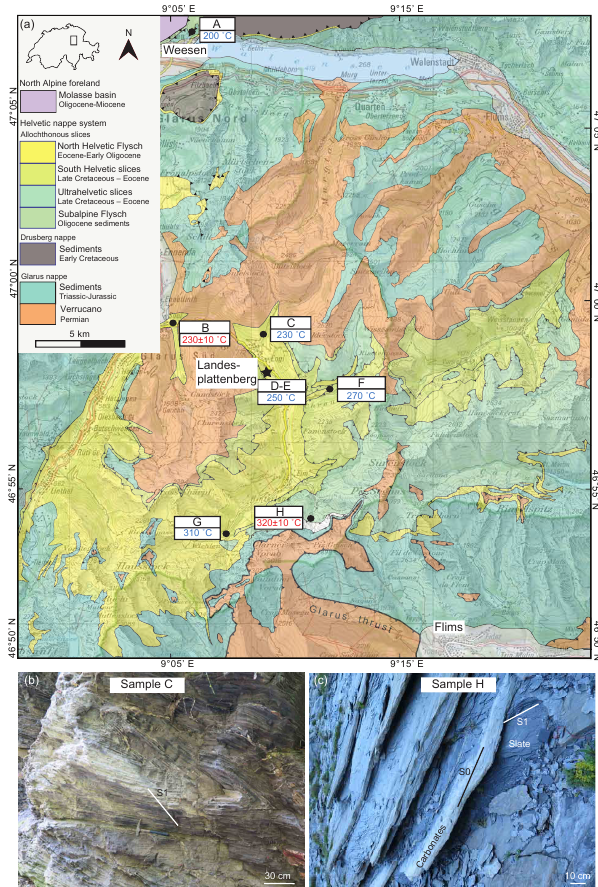
Figure 1. Geological map and outcrops. (a) Geological map with sample locations. Map adapted from Dielforder et al. (2016); temperatures from samples in close vicinity taken from Ebert et al. (2007) (in red) and from Lahfid et al. (2010) (in blue). Star indi- cates location of sub-surface samples. (b) Outcrop of folded slates at Engi with secondary foliation (46 ◦ 59 (cid:48) 13.9 (cid:48)(cid:48) N, 9 ◦ 09 (cid:48) 17.6 (cid:48)(cid:48) E). (c) Outcrop of slates at Martinsmad (46 ◦ 53 (cid:48) 31.2 (cid:48)(cid:48) N, 9 ◦ 11 (cid:48) 15.5 (cid:48)(cid:48) E) intercalated with massive carbonaceous layers. S0: bedding; S1: fo-